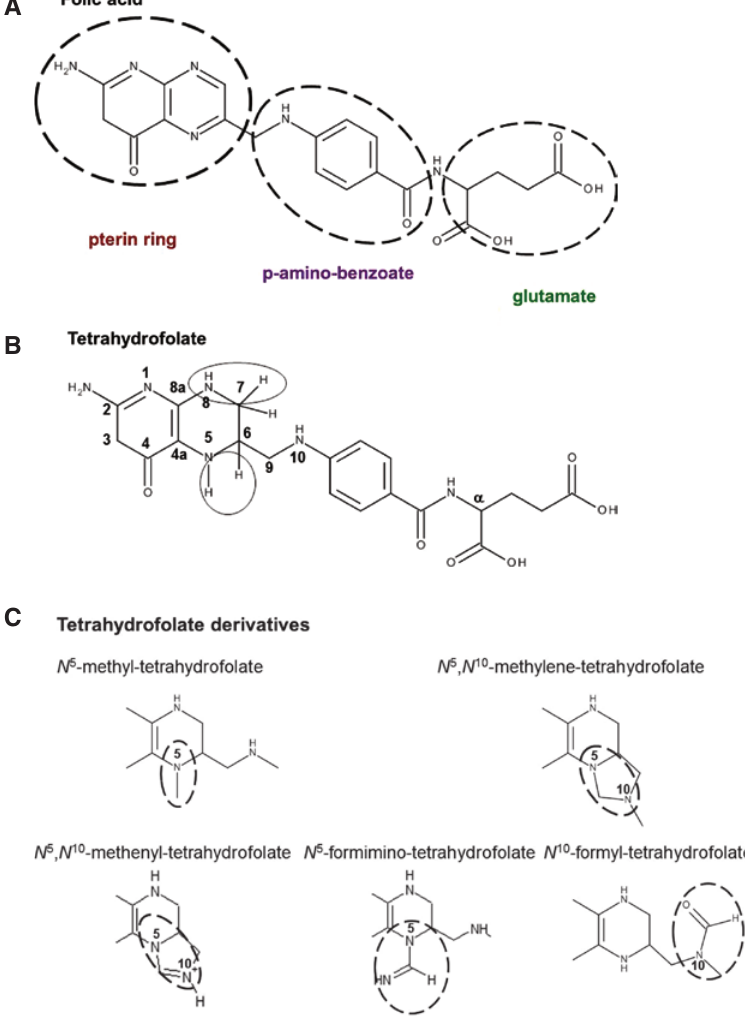
Figure 1: Chemical structures of folic acid (A), tetrahydrofolate (B) and its derivatives (C).